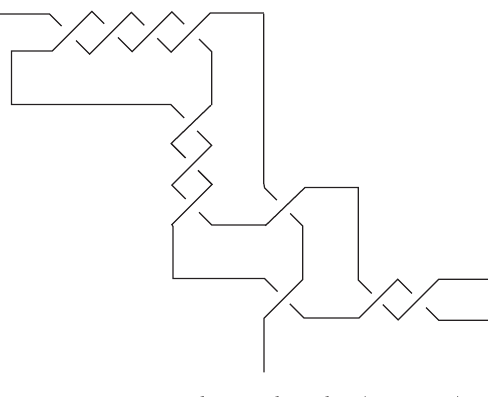
Figure 3: Canonical rational tangle 𝑅(2,1,1,3,4)